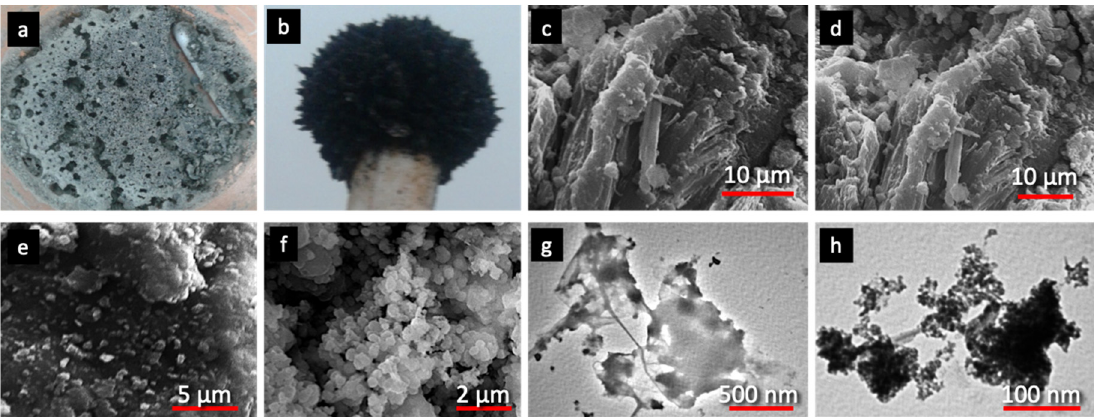
Figure 2. Photographs of serpentine (SP) ( a ) and magnetic Fe 3 O 4 nanoparticles (MNP) ( b ), scanning electron microscopy (SEM) images of SP ( c ) and MNP/SP ( d – f ), transmission electron microscopy (TEM) images of SP ( g ) and MNP/SP ( h ).